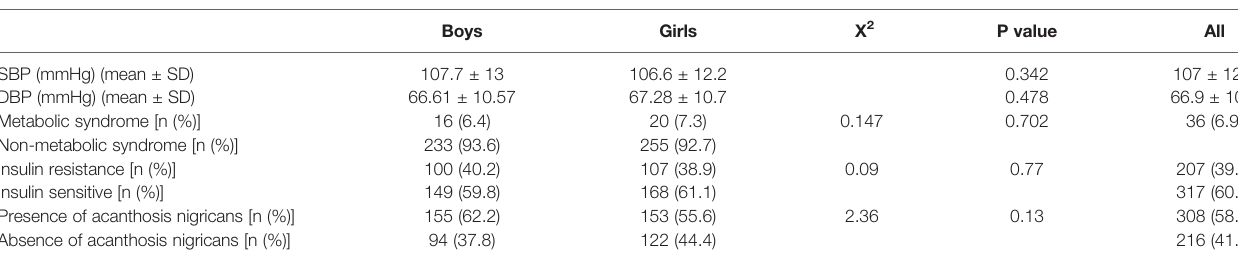
TABLE 3 | Clinical measures.